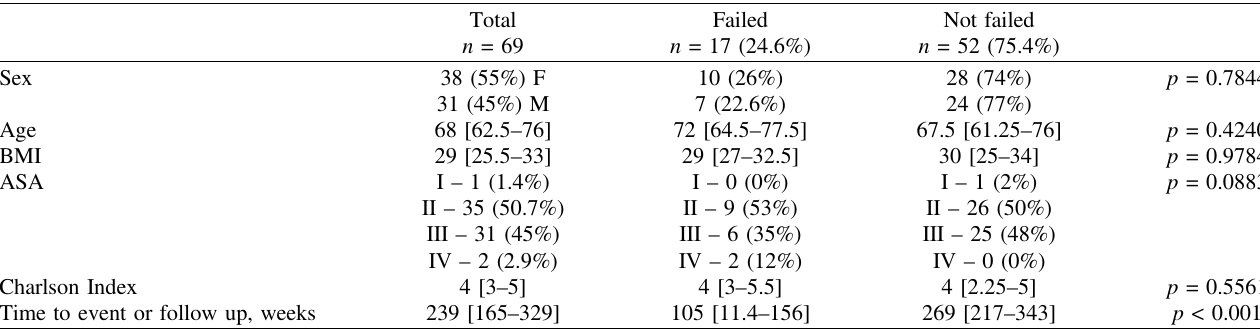
Table 1. General characteristics of patients included in the observation.